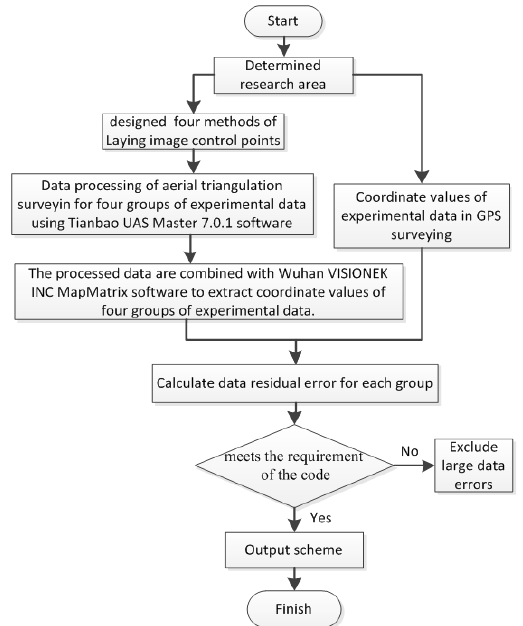
Figure 5. Flow chart of lay Leveling control point at four corners + Interlaced and evenly distributed elevation control points of the zone